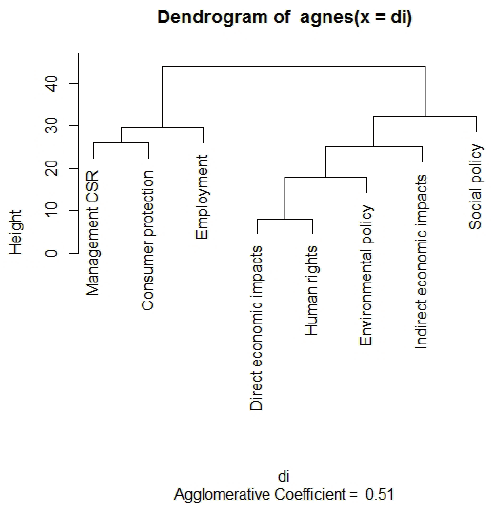
Fig. 1 - Dendogram of similarity. Source: